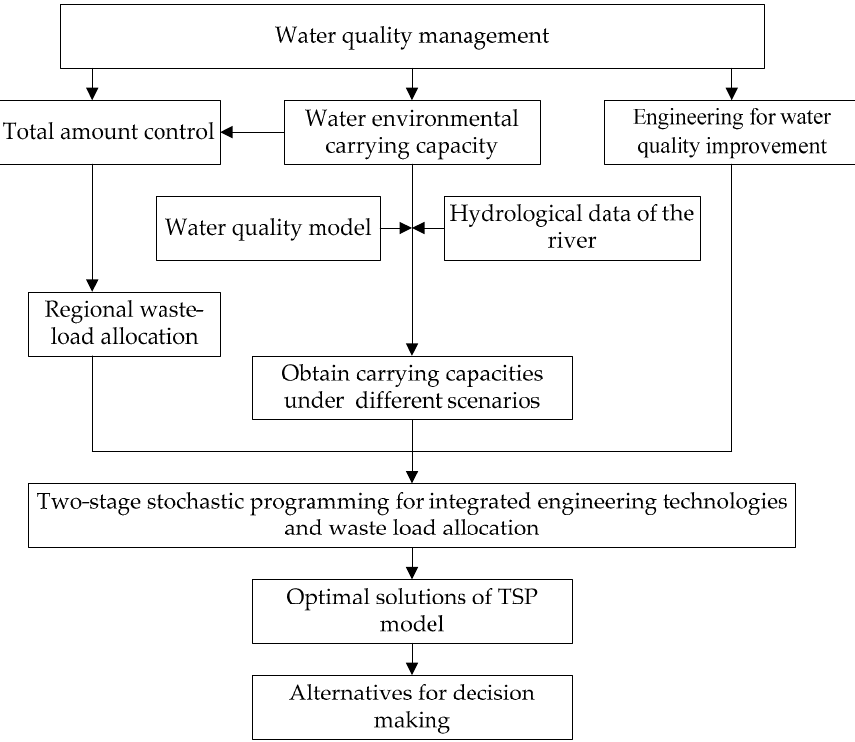
Figure 2. Framework of the two-stage stochastic programming model .